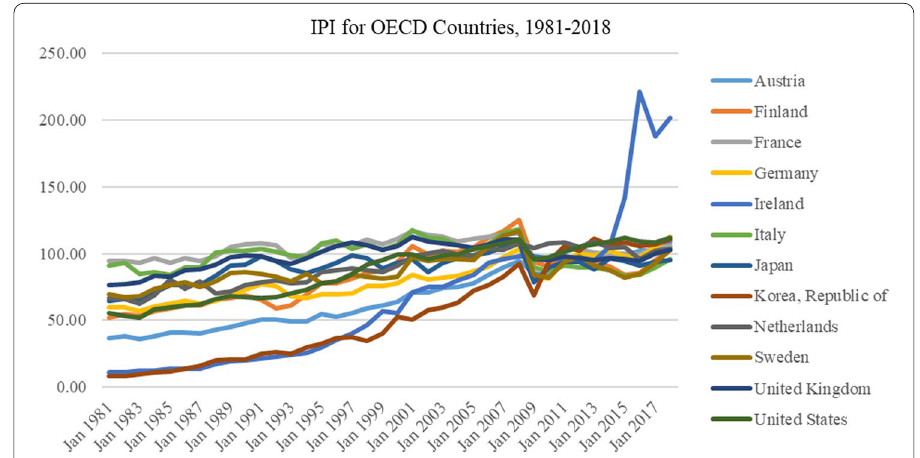
Fig. 1 IPI for OECD countries for the period 1981–2018. Source : International Monetary Fund database